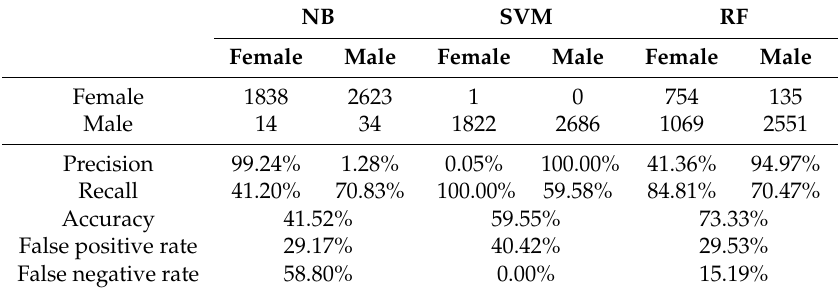
Table 6. The accuracy of gender detection using entire feature set (word features + sentiment features).